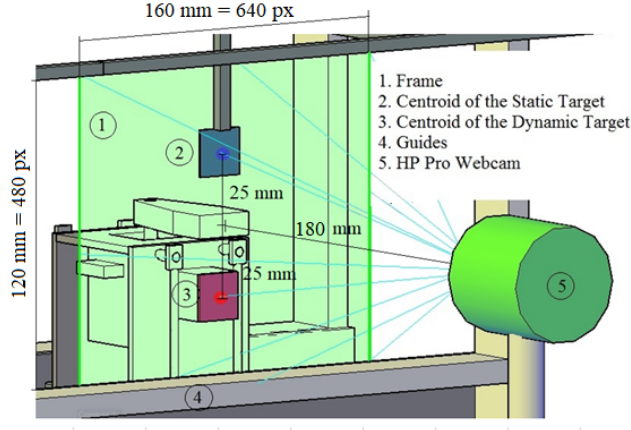
Figure 5. Elements of the machine vision system in a frame. Dimensions of frames in pixels and millimeters also are shown. The video frame and the line of sight of the camera lens were perpendicular.